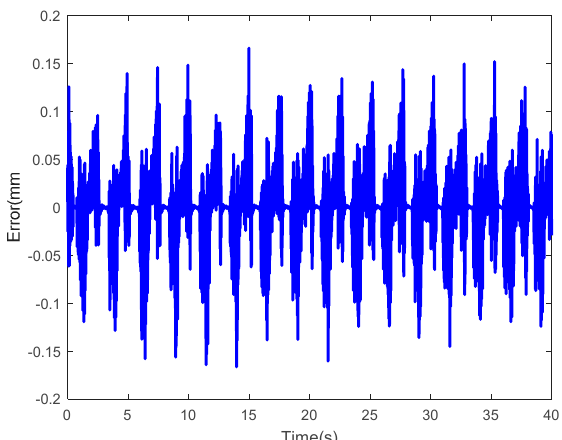
Figure 48. Input displacement is the control error at a frequency of 1/2 π Hz and an amplitude of 2.5mm.